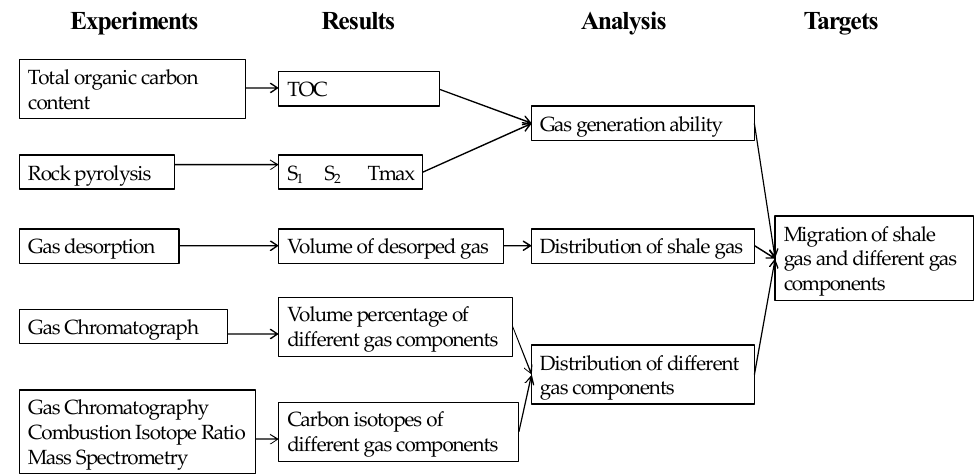
Figure 2. Chart showing the workflow and purpose of experiments. The total organic carbon content was measured using Vario TOC. The experimental procedures were as follows: (1) the solid rock was milled into powder of less than 100 mesh; (2) hydrochloric acid solution (5% dilute) and powder samples were placed in the fume hood for ventilation (three days) to remove carbonate; (3) the samples were placed